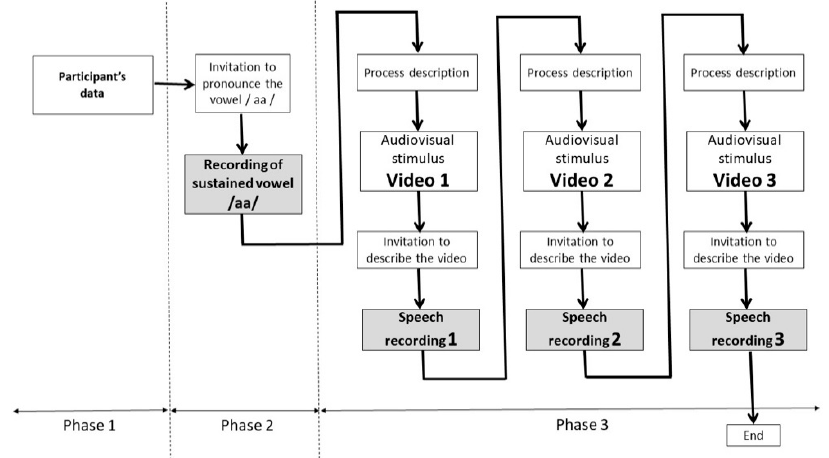
Figure 5. Flow chart describing the software PROGNOSIS.